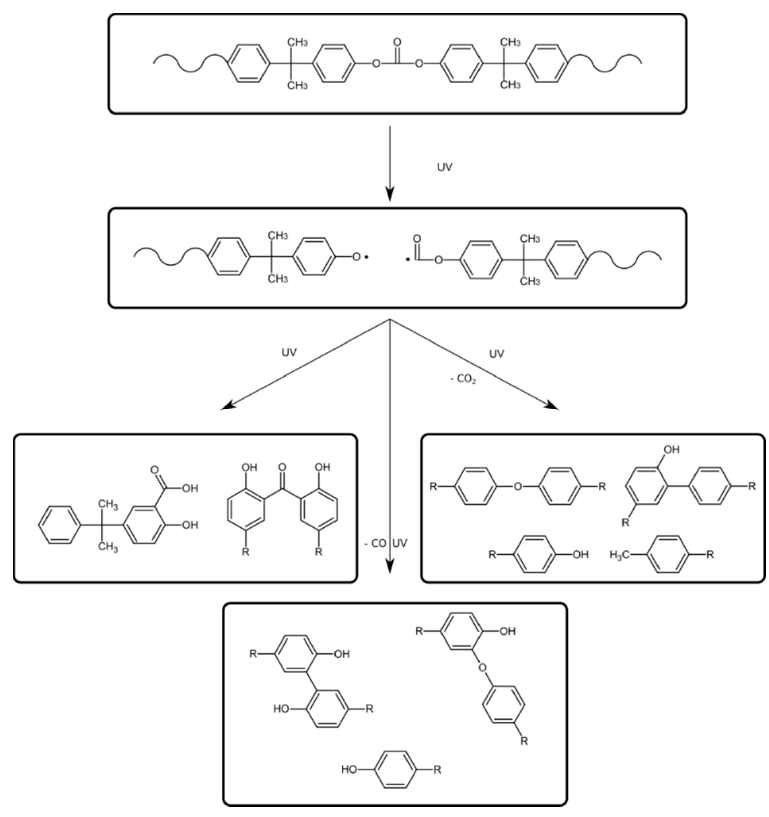
Figure 1. Photo-oxidative degradation of polycarbonate.